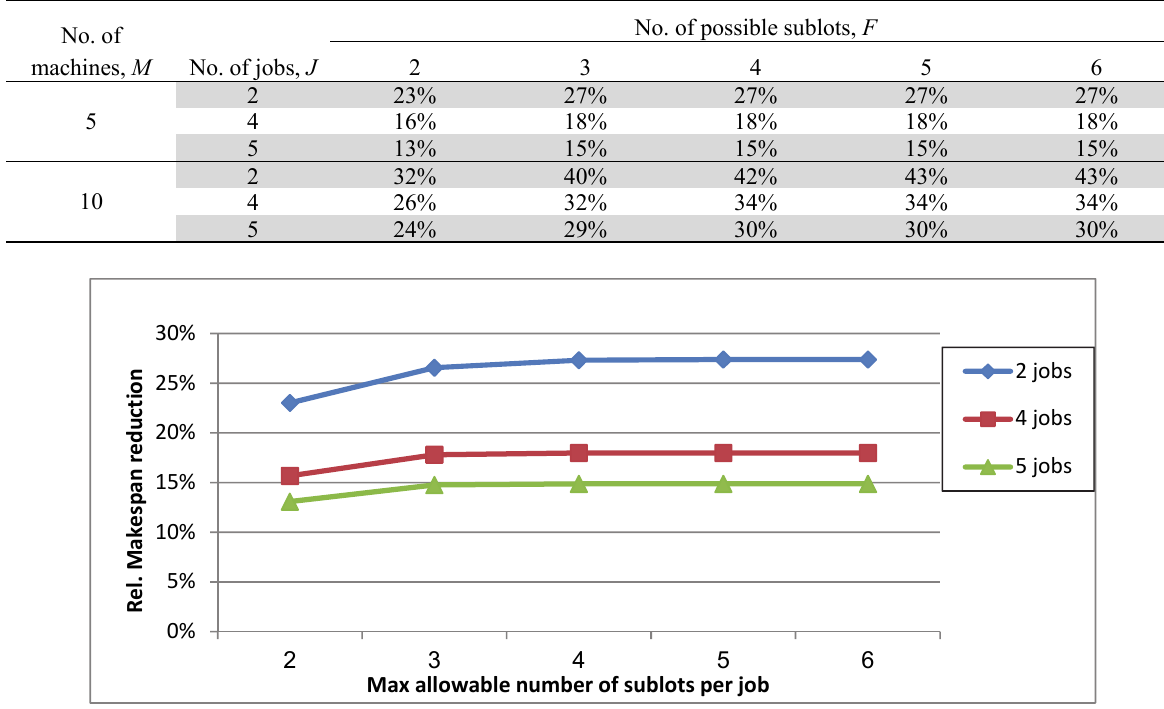
Fig. 1. Makespan reduction with respect to the maximum allowable number of sublots per